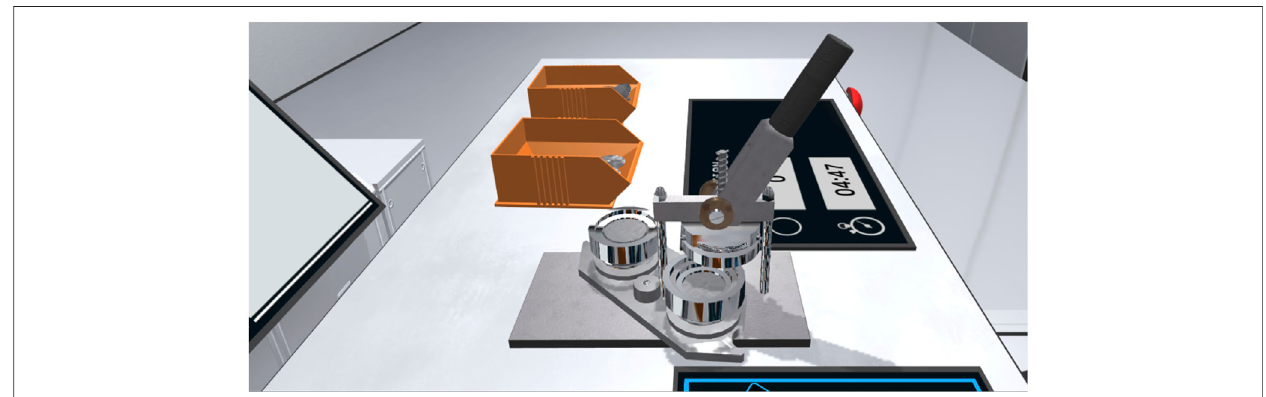
FIGURE3| TheParticipantsoperatedthevirtualpin-backbuttonpressincollaborationwiththerobotarm.Theimplementedinteractionmechanicsemulatedthe physical button press and enabled participants to use the lever and the rotation tray. Authentic sound and haptic feedback completed the representation.